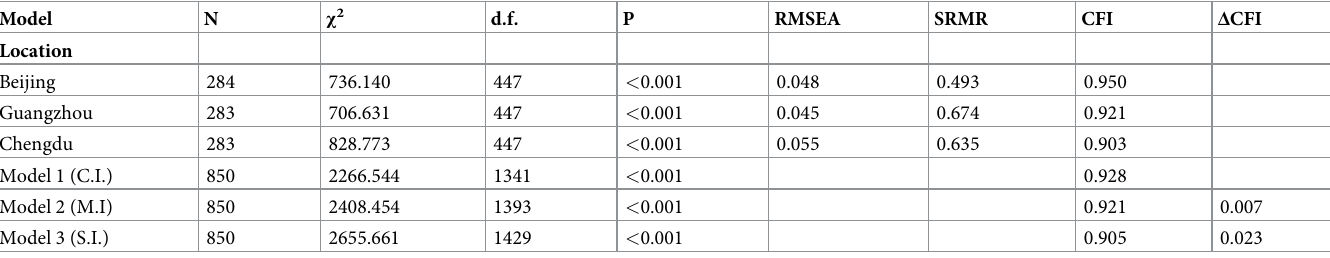
Table 8. Goodness of fit indices for tests of multi-group